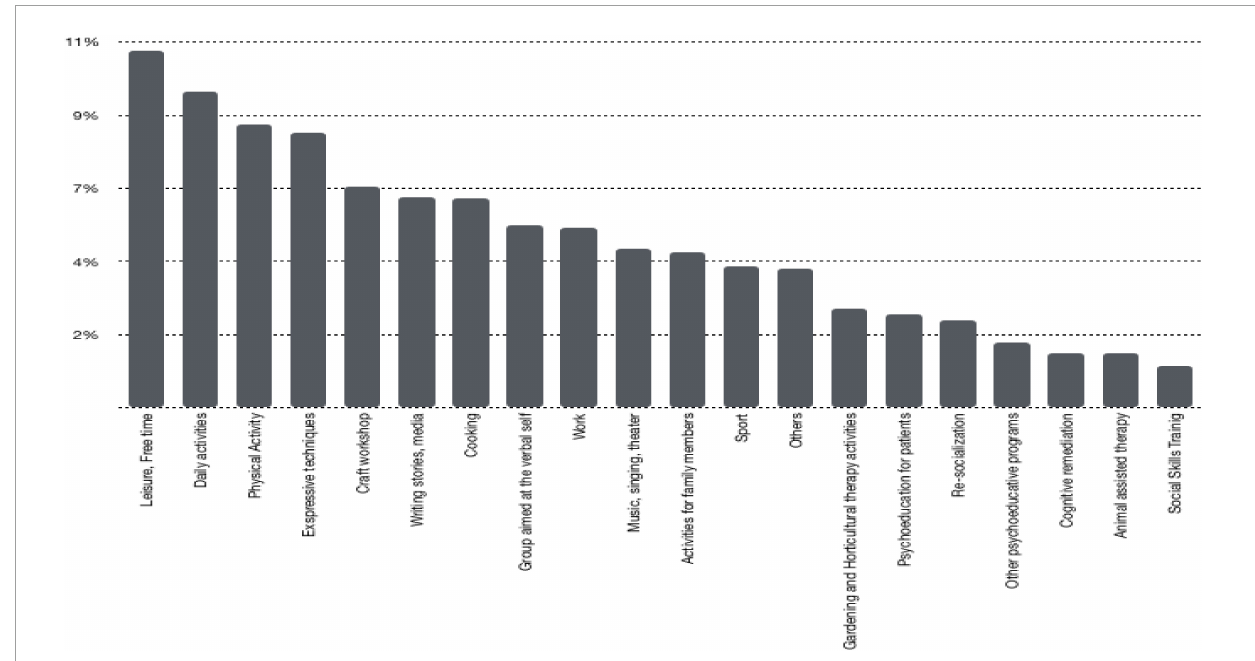
FIGURE1 National distribution of the frequency of categories related to the rehabilitation activities, according to Italian Society for Psychosocial Rehabilitation (SIRP)